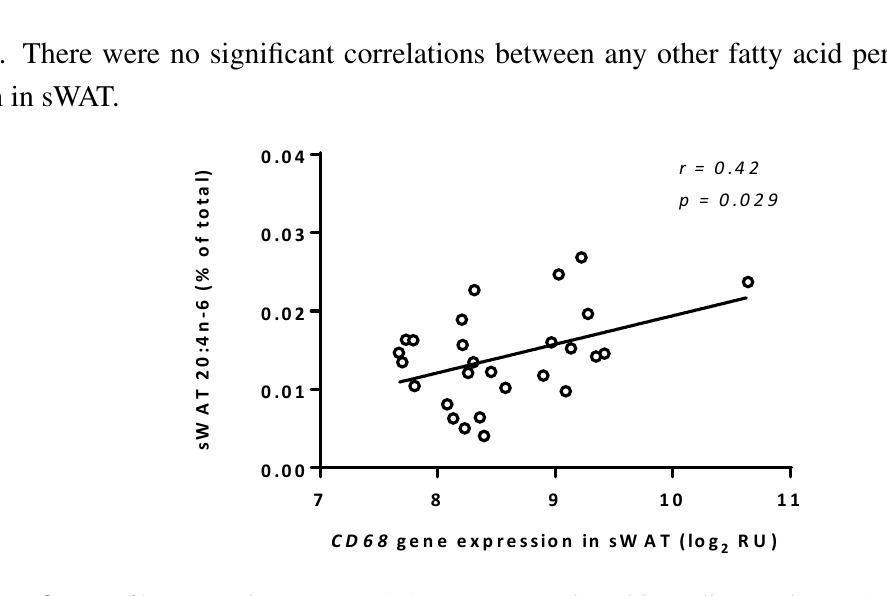
Figure 2. CD68 expression versus AA percentage in white adipose tissue (sWAT). Linear regression of sWAT gene expression of the macrophage marker CD68 with the sWAT percentage of 20:4 n -6 (AA). Data are log transformed normalized gene expression levels (relative units [RU]: log2-scale). Data are expressed as mean ±standard deviation (SD).